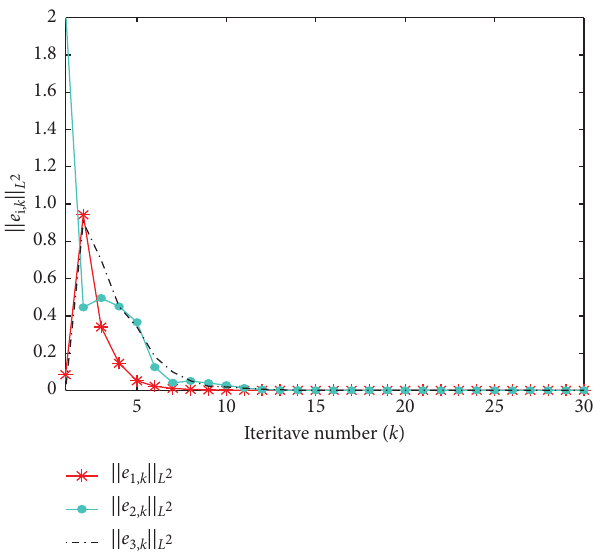
Figure 6: Changes in the consensus error between the three agents and the virtual leader agent in nonlinear parabolic partial